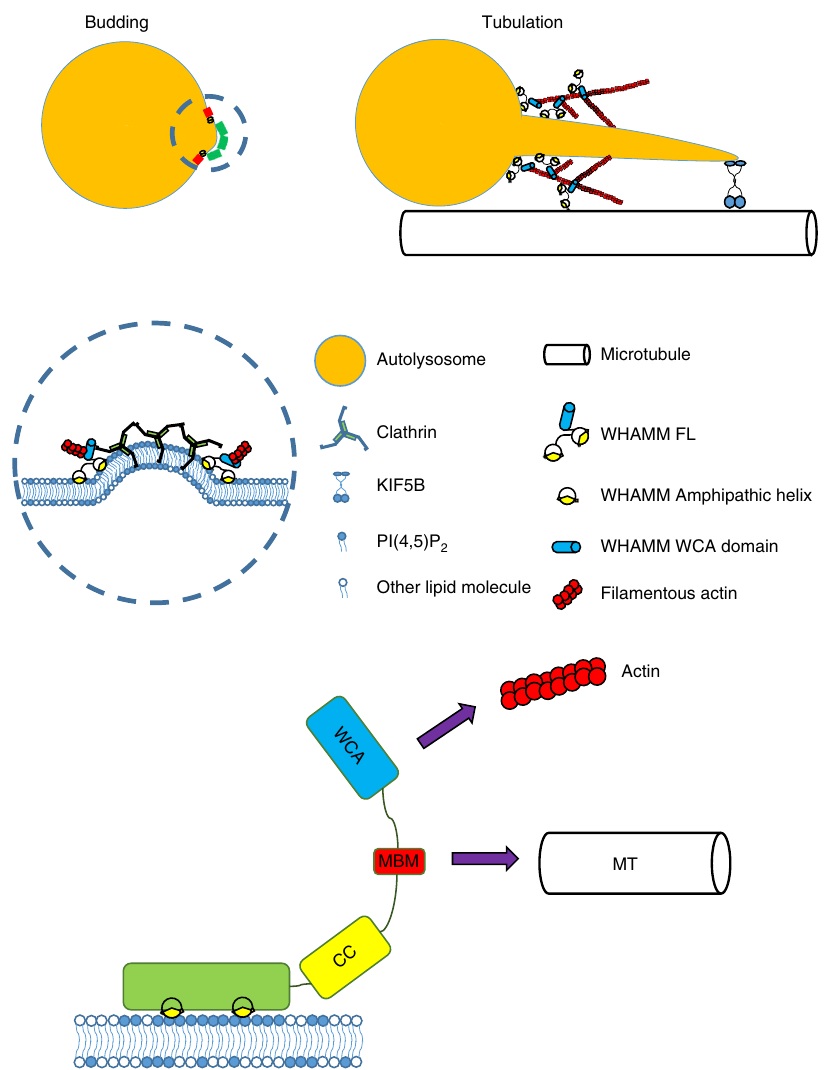
Fig. 8 WHAMM promotes actin polymerization during autolysosome reformation. A schematic drawing showing the role of WHAMM during Clathrin- mediated autolysosome reformation. In brief, WHAMM binds to locally enriched PI(4,5)P 2 near Clathrin buds and generates branched actin networks to facilitate budding and tubulation of the